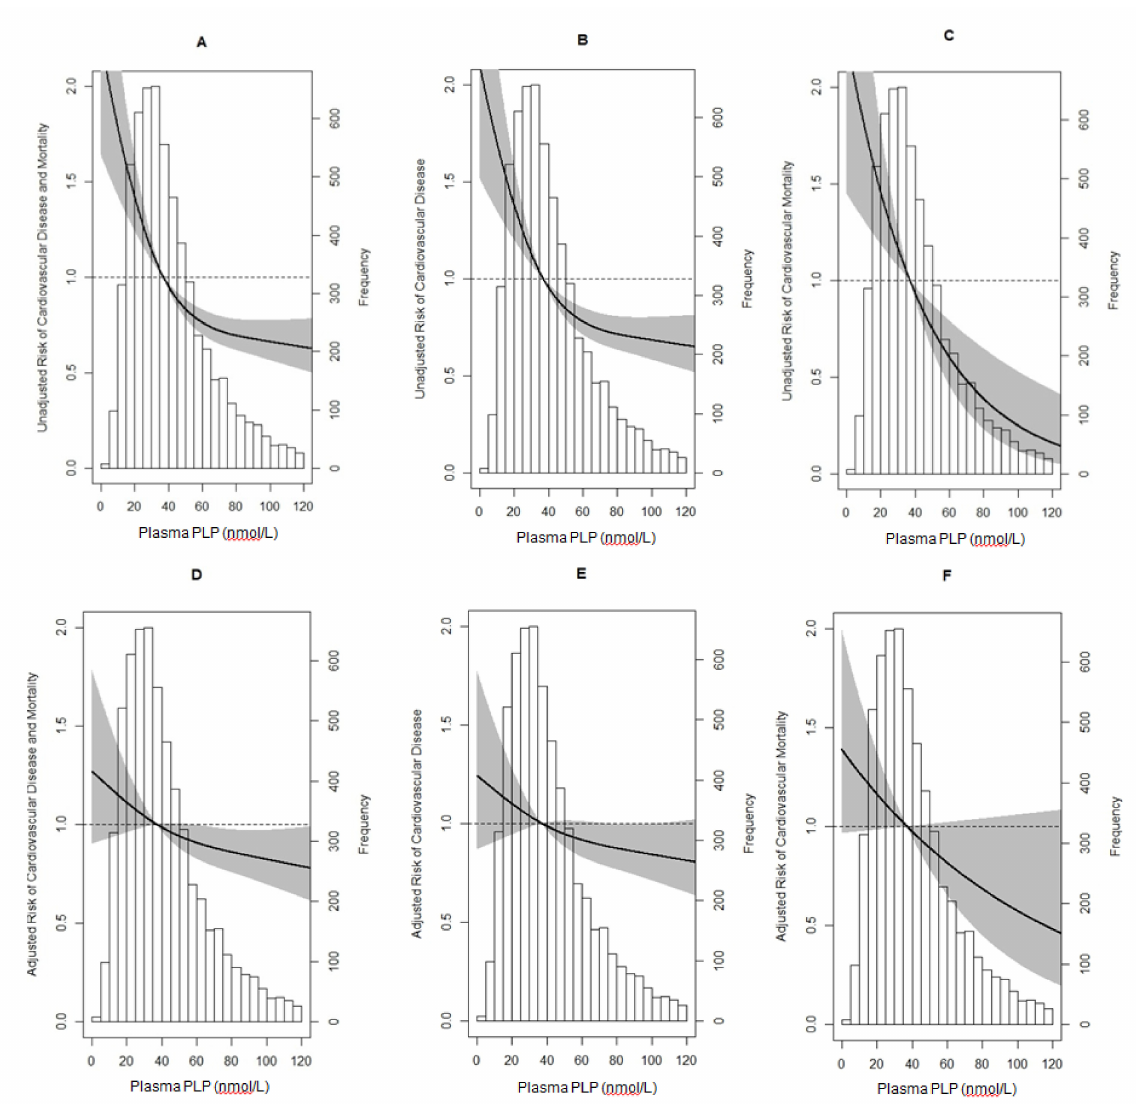
Figure 1. Unadjusted and fully adjusted continuous associations between plasma pyridoxal 5’-phosphate and cardiovascular outcome. Unadjusted associations for the composite cardiovascular outcome (figure A , P nonlinearity < 0.001), cardiovascular disease (figure B , P nonlinearity = 0.002), and cardiovascular mortality (figure C , P nonlinearity = 0.10) were collectively adjusted for age, sex, smoking, alcohol consumption, BMI, eGFR, albumin excretion, total cholesterol:HDL-cholesterol ratio, systolic and diastolic blood pressure, hs-CRP, and GlycA (figures D – F , respectively). Abbreviations: hs-CRP, high-sensitivity C-reactive protein; BMI, body mass index; HDL, high-density lipoprotein; eGFR, estimated glomerular filtration rate; PLP, pyridoxal